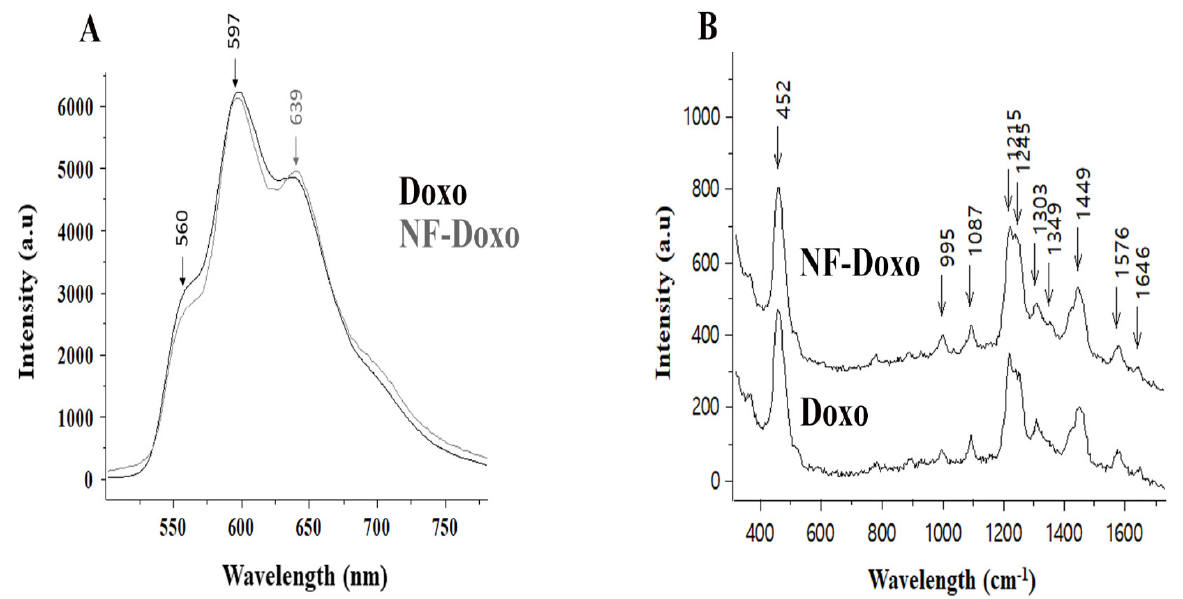
Figure 8. Fluorescence ( A ) and SERS ( B ) spectra of Doxo: free drug in aqueous solution compared with NF-Doxo in aqueous suspension.